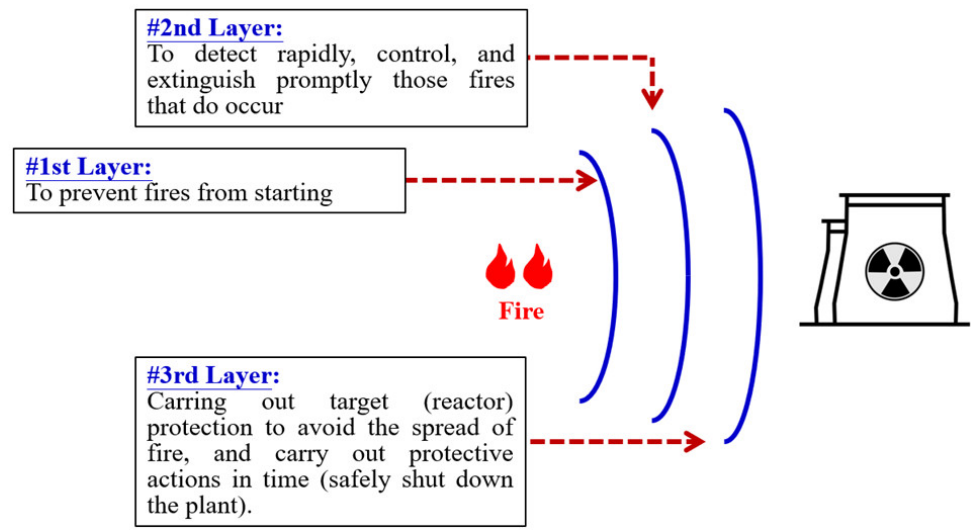
Figure 1. Fire protection defense-in-depth strategy in U.S. nuclear power plants.